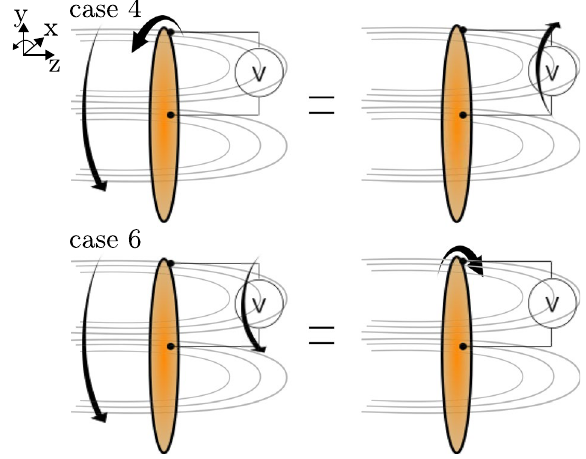
Figure 7. Relative motion of the magnetic field (which is assumed as co-rotating) compared to the